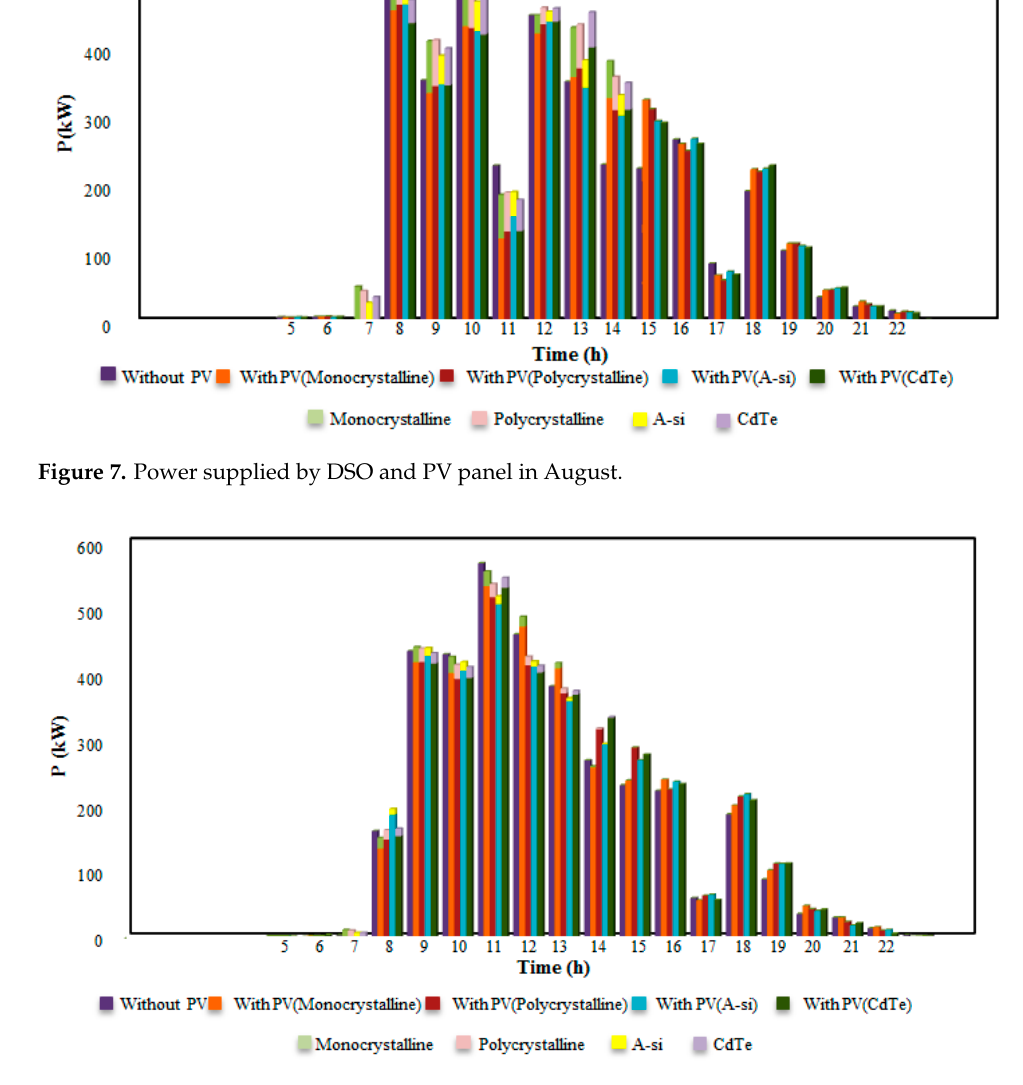
Figure 8. Power supplied by DSO and PV panel in November.